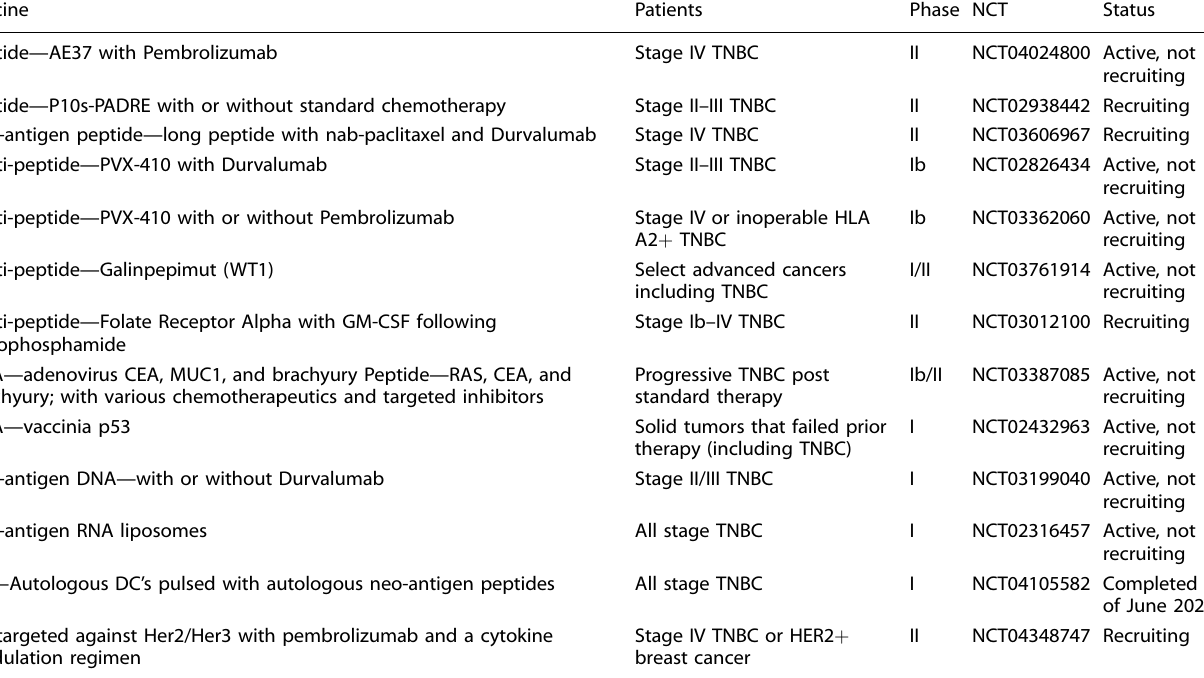
Table 1. Clinical trials for breast cancer treatment using vaccine therapy in